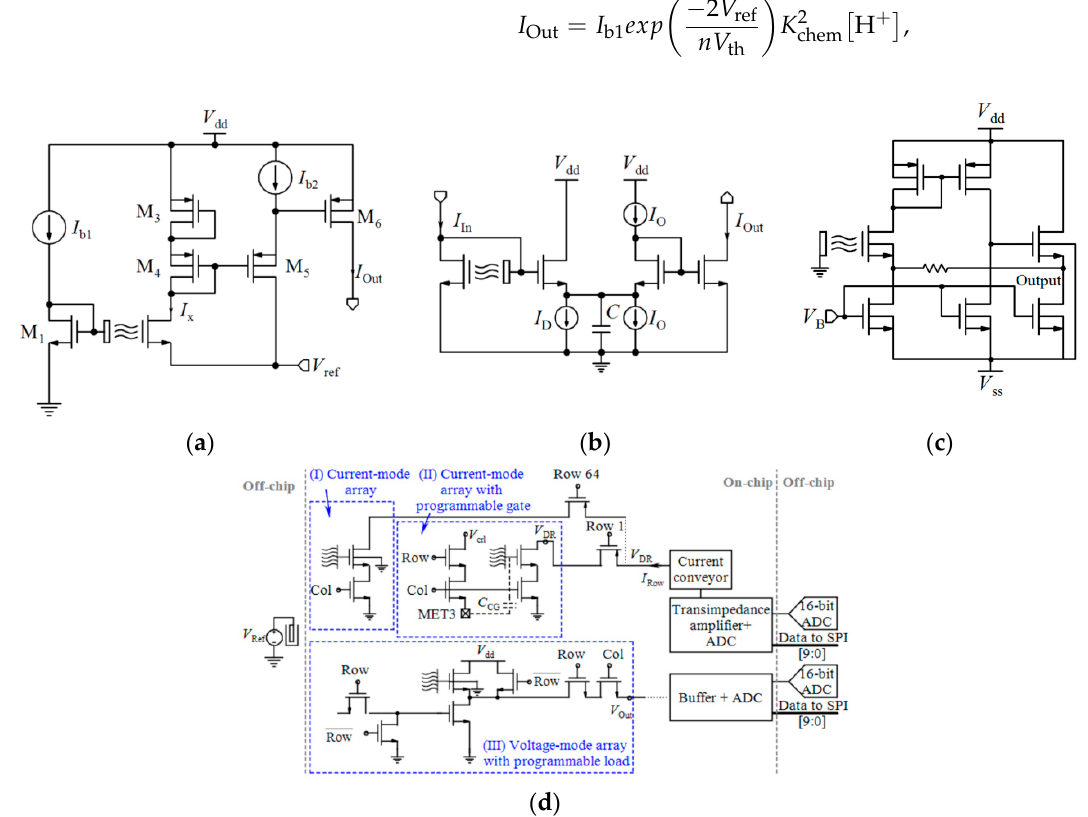
Figure 26. ( a ) HCell with the translinear operation; ( b ) a log-domain filter with an ISFET used at its input; ( c ) a current-mode readout with current feedback; ( d ) schematic of a system including three configurations: (I) Current-mode configuration in a 64 × 200 array, (II) current-mode PG pixel architecture in a 64 × 200 array, (III) voltage-mode pixel structure in a 64 × 128 array.